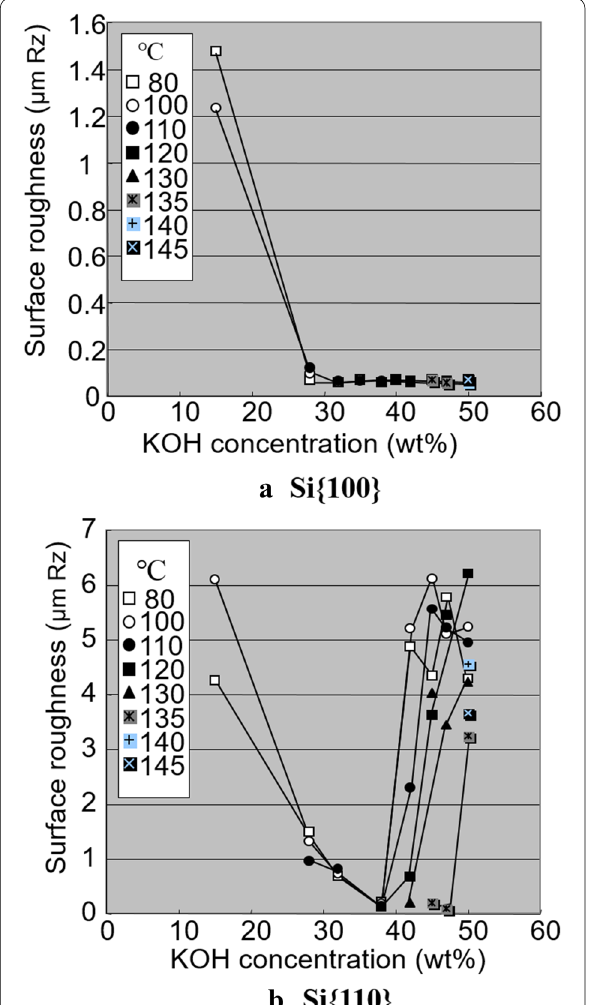
Fig. 18 Etched surface roughness of a Si{100} and b Si{110} in KOH solutions in a concentration range from 15 to 50 wt% [18], © 2004, Elsevier